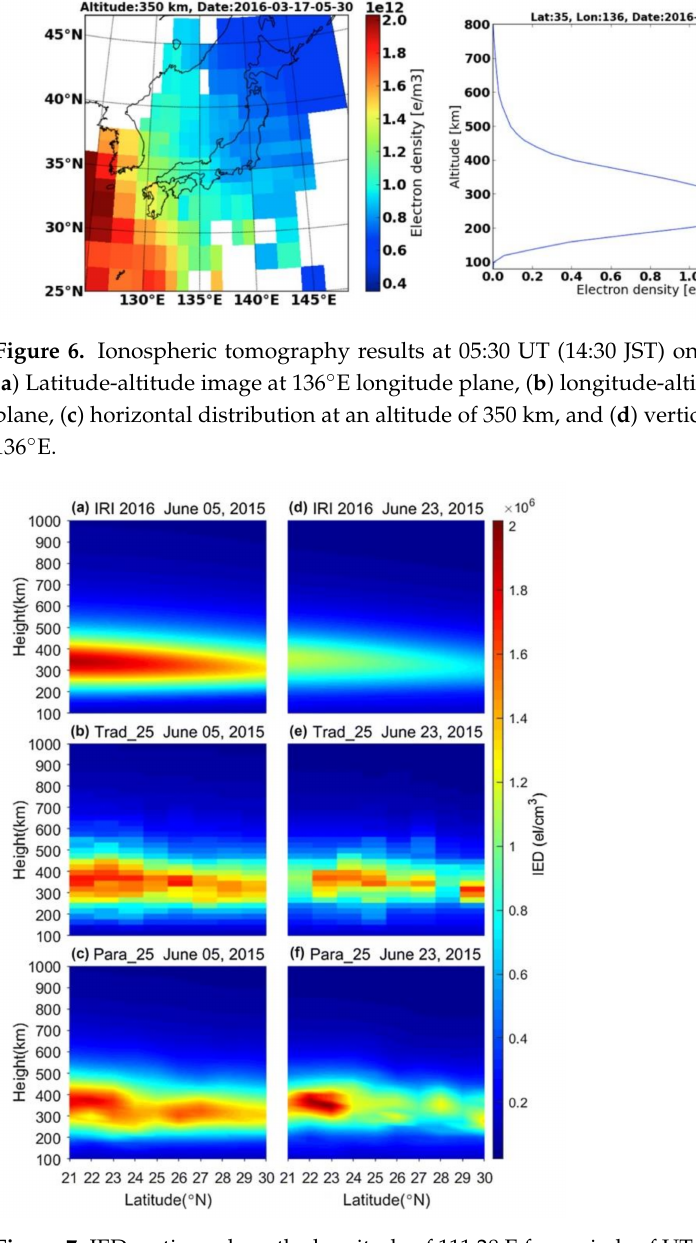
Figure 7. IED sections along the longitude of 111.28 E for periods of UT 7–8 on 5 June 2015 ( a – c ) and UT 5–6 on 23 June 2015 ( d – f ) (from [33]). ( a , d ) IED images derived from IRI 2016 model, ( b , e ) tomog- raphy with uniform IED in the voxel, and ( c , f ) tomography with parameterized IED in the voxel. The vertical resolution is 25 km and the horizontal resolution is 2 ◦ × 2 ◦